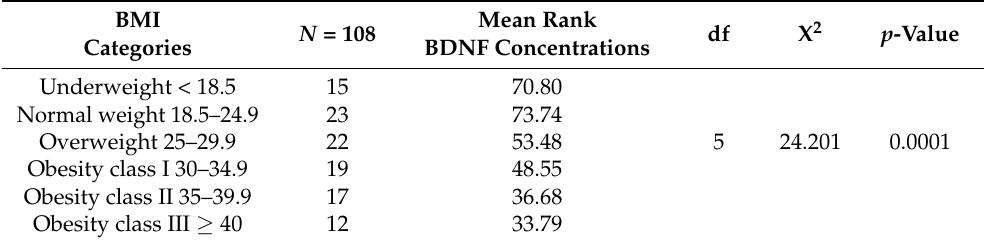
Table 3. Post hoc analysis of serum BDNF levels between different BMI categories. Group vs. Group p -Value *